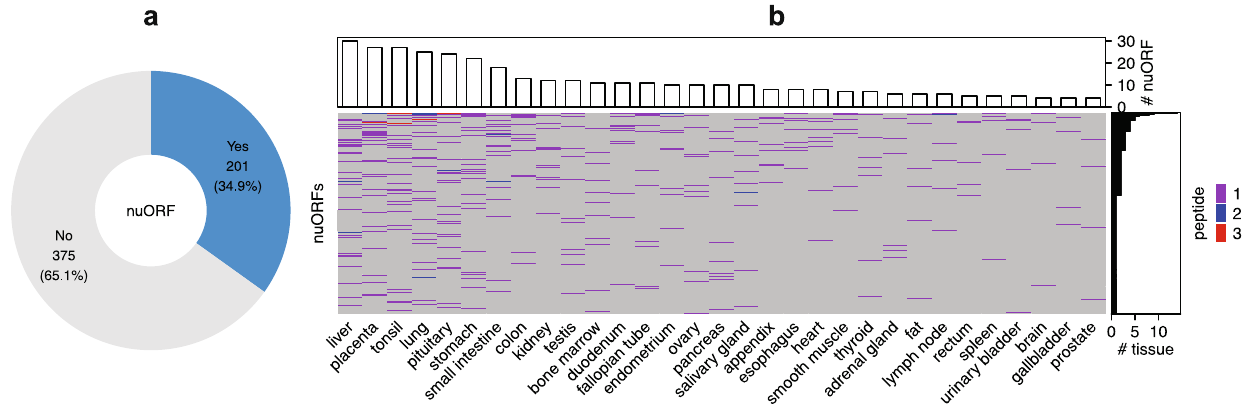
Fig.5|Prioritizationoftumor-speci fi cantigens.a Summaryofidenti fi cationresultsforquerying576nuORFsagainstapublicproteomicsdataseton31healthytissues. b The distribution of nuORF identi fi cations across different healthy tissues. Source data are provided as a Source Data fi